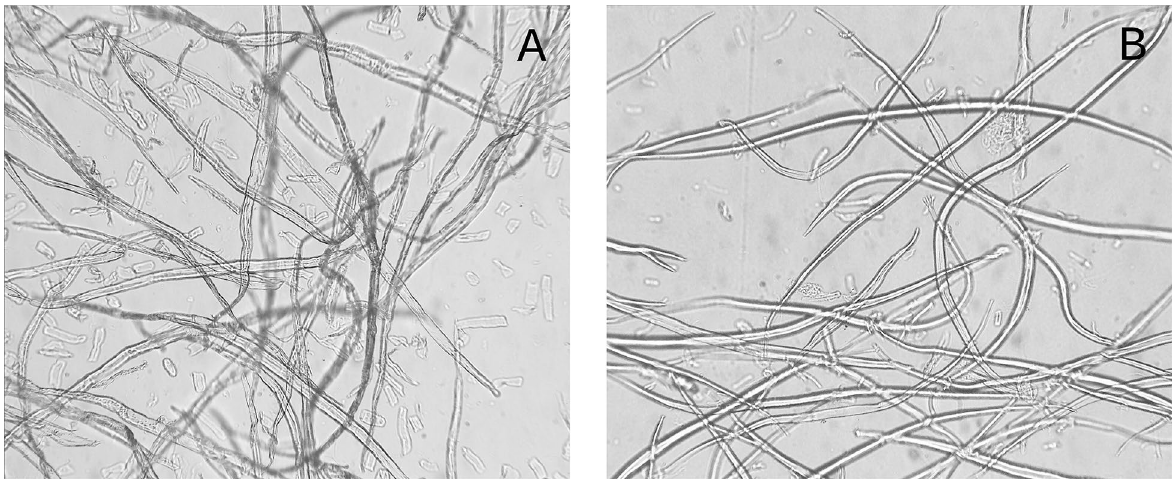
Figure 1. The optical micrographs of the hardwood pulp immersed in the distilled water ( A ) and 17.5% NaOH solution. Samples were incubated for 40 min before the